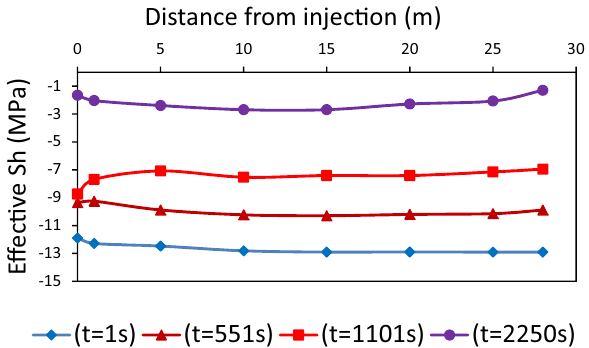
Fig. 12 Case 2 ( k = 45.9 mD): Effective minimum horizontal stress versus distance along SRV width from the injection port at different injection times